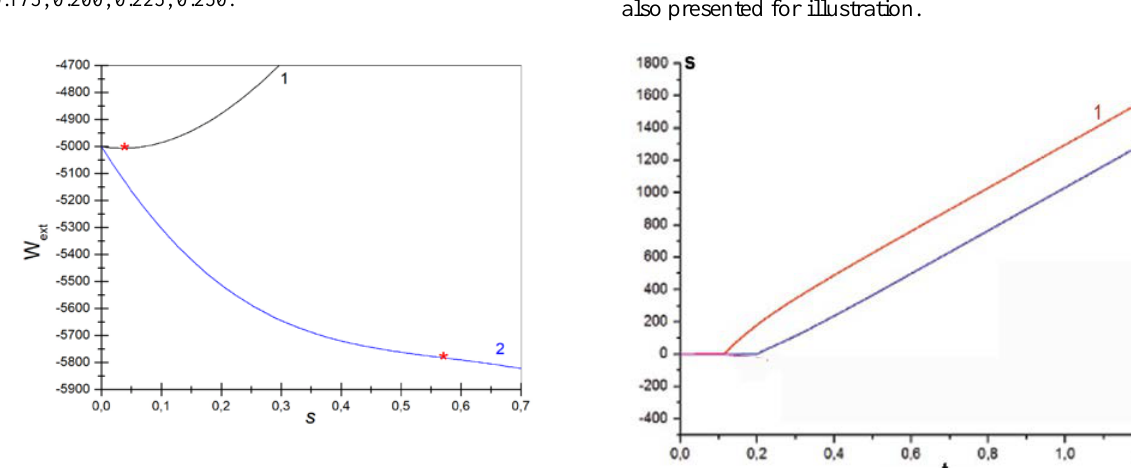
Fig. 2. Vortex line evolution under the effect of supercritical current pulse, curves 1 – 8: t = 0.025, 0.100, 0.125, 0.150, 0.175, 0.200, 0.225, 0.250.